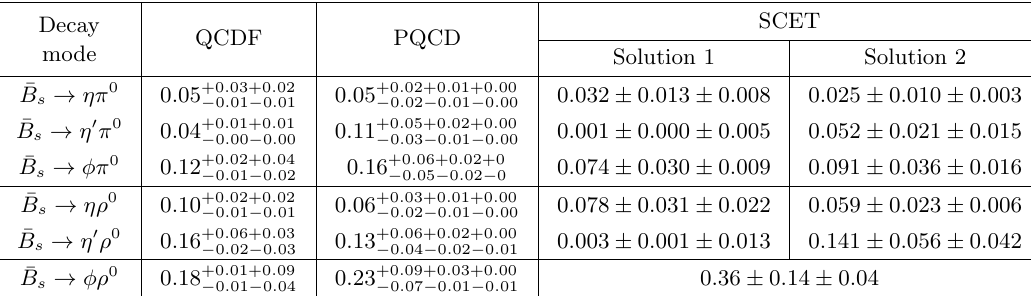
Table 2 . Branching fractions, in units of 10 (cid:0) 6 , of (cid:22) B s ! ( (cid:17); (cid:17) 0 ; (cid:30) )( (cid:25) 0 ; (cid:26) 0 ) decays in the SM. For the (cid:12)rst (cid:12)ve modes, the last two columns correspond to the two solutions of SCET parameters in eq. (3.8). The errors of the SCET predictions are due to assumed 20% (cid:13)avor-SU(3)-breaking e(cid:11)ects and the errors in the (cid:16) s from (cid:12)ts to data, respectively. For comparison, the second and